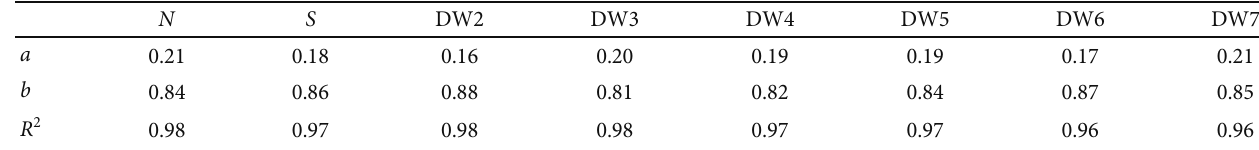
Table 4: Fitting values of the hyperbolic